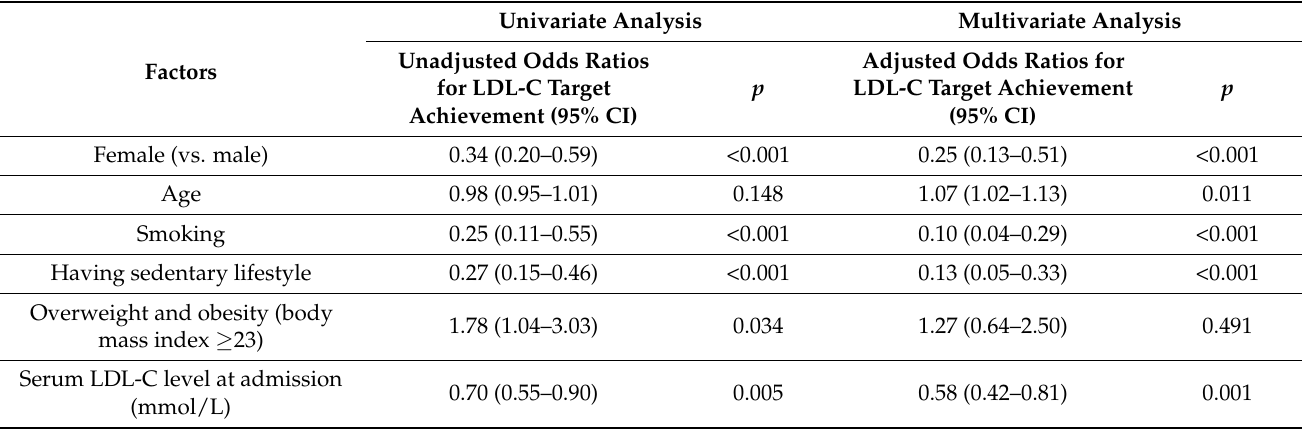
Table 4. Univariate and multivariate logistic regression of sex and other factors on low-density lip- oprotein cholesterol target achievement.